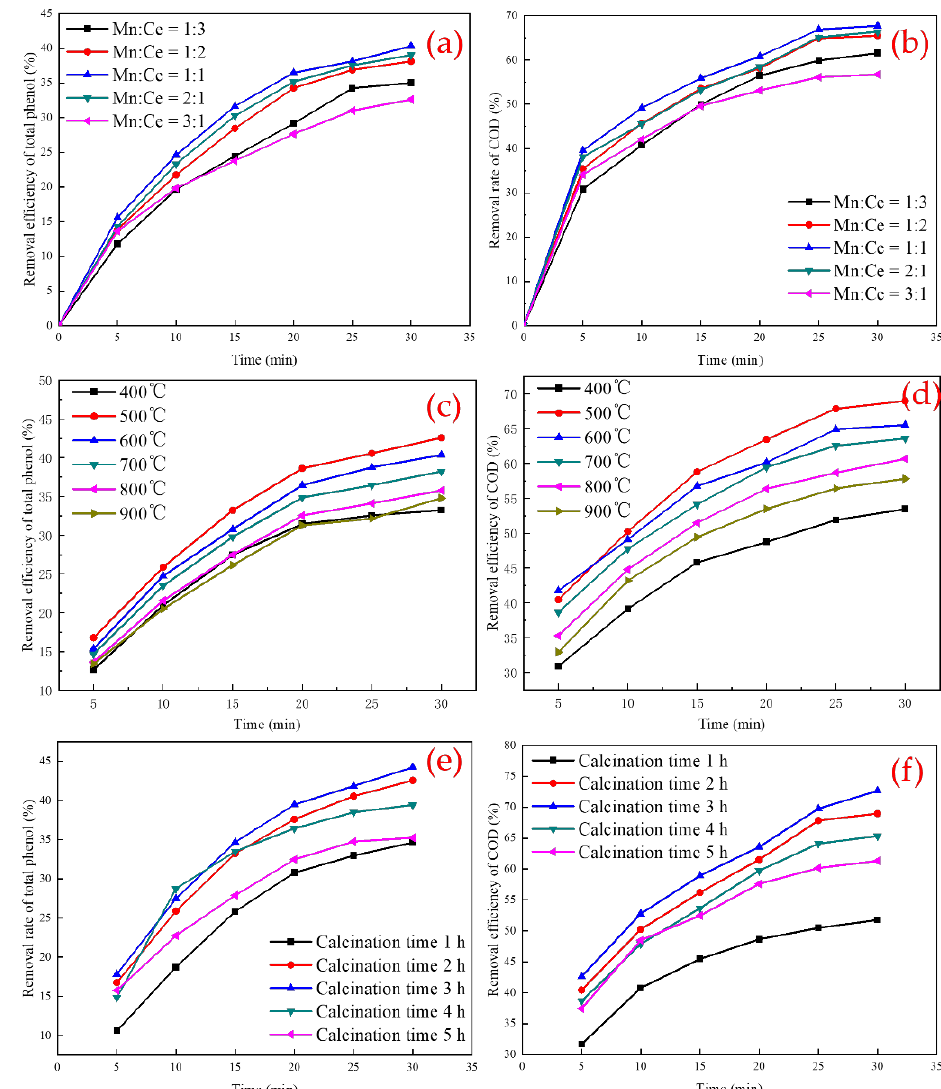
Figure 1. Effect of different preparation conditions on total phenol and COD removal efficiencies: ( a ) effect of Mn:Ce doping ratio on total phenol removal efficiency; ( b ) effect of Mn:Ce doping ratio on COD removal efficiency; ( c ) effect of calcination temperature on total phenol removal efficiency; ( d ) effect of calcination temperature on COD removal efficiency; ( e ) effect of calcination time on total removal efficiency; ( f ) effect of calcination time on COD removal efficiency. Table 1. Water quality analysis of coal chemical biochemical tailwater.